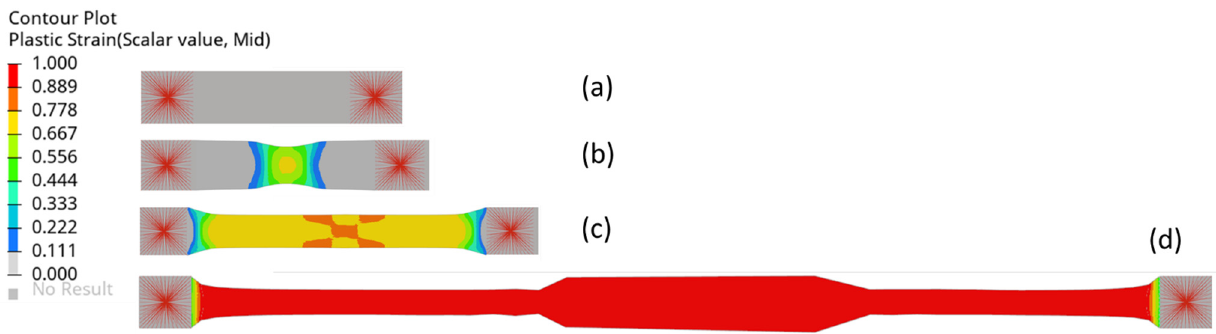
Figure 15. FE results showing the loading phases in the TD direction at initial stage ( a ), after first localization occurs ( b ), then proceeding through the specimen ( c ) and shortly before failure ( d ).